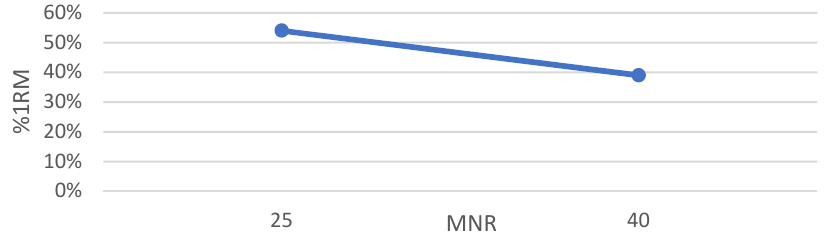
Figure 10. MNR vs. Figure 10. MNR vs. %1RM.